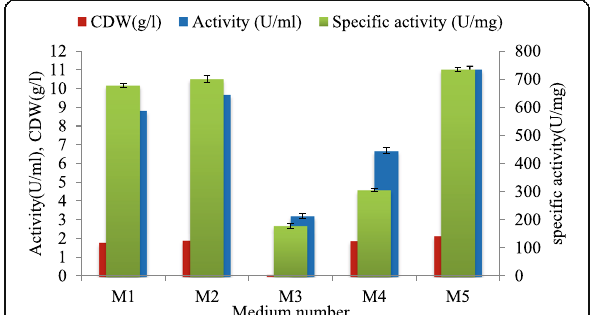
Fig. 3 Production of α -amylase by Bacillus sp. NRC22017 in five different fermentation media. Data were expressed as mean ± standard